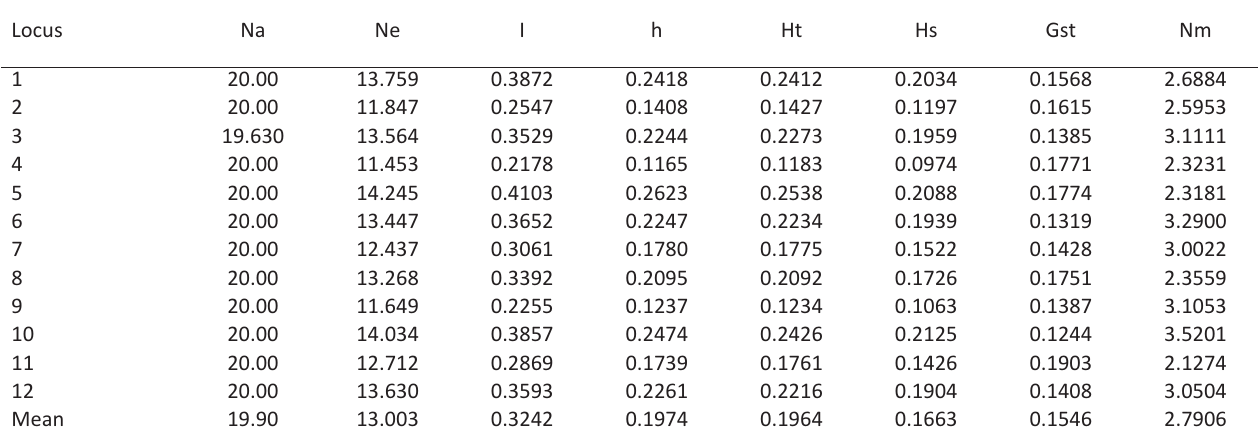
Table 4 ­ A summary of genetic parameters across inter­simple sequence repeat loci Locus Na